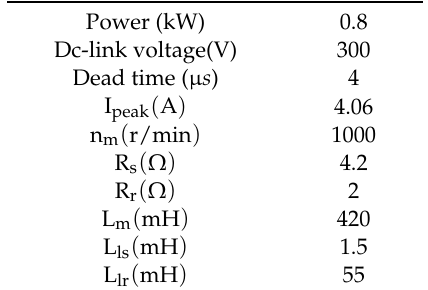
Figure 6. Experimental test bench. Table 1. Electric drive parameters.